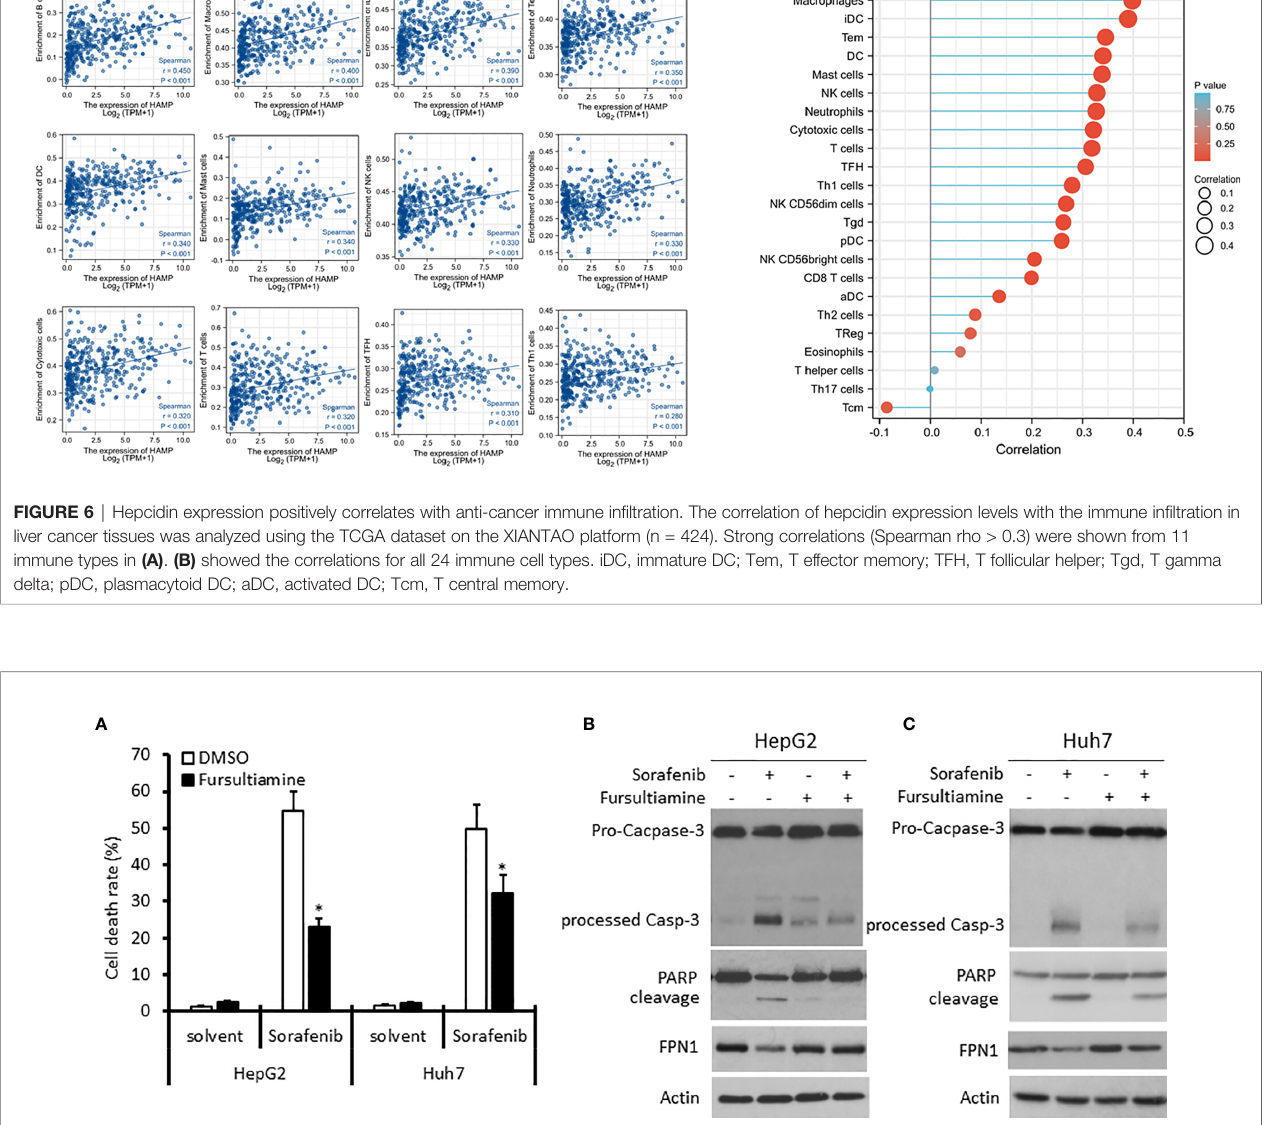
in fi ltration pro fi les.